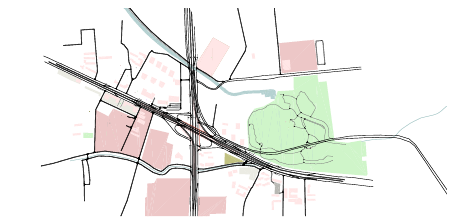
Figure 5. View of Zizhuyuan Road, Pékin, Chine, in